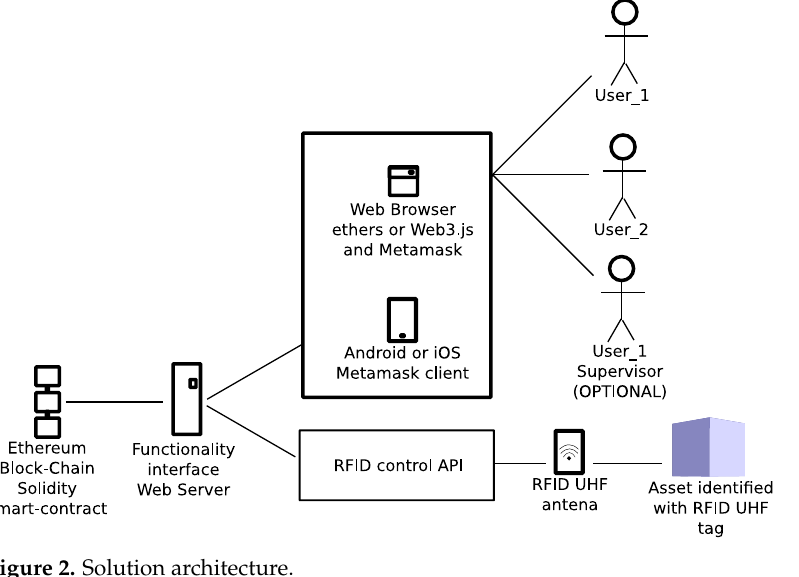
Figure 2. Solution